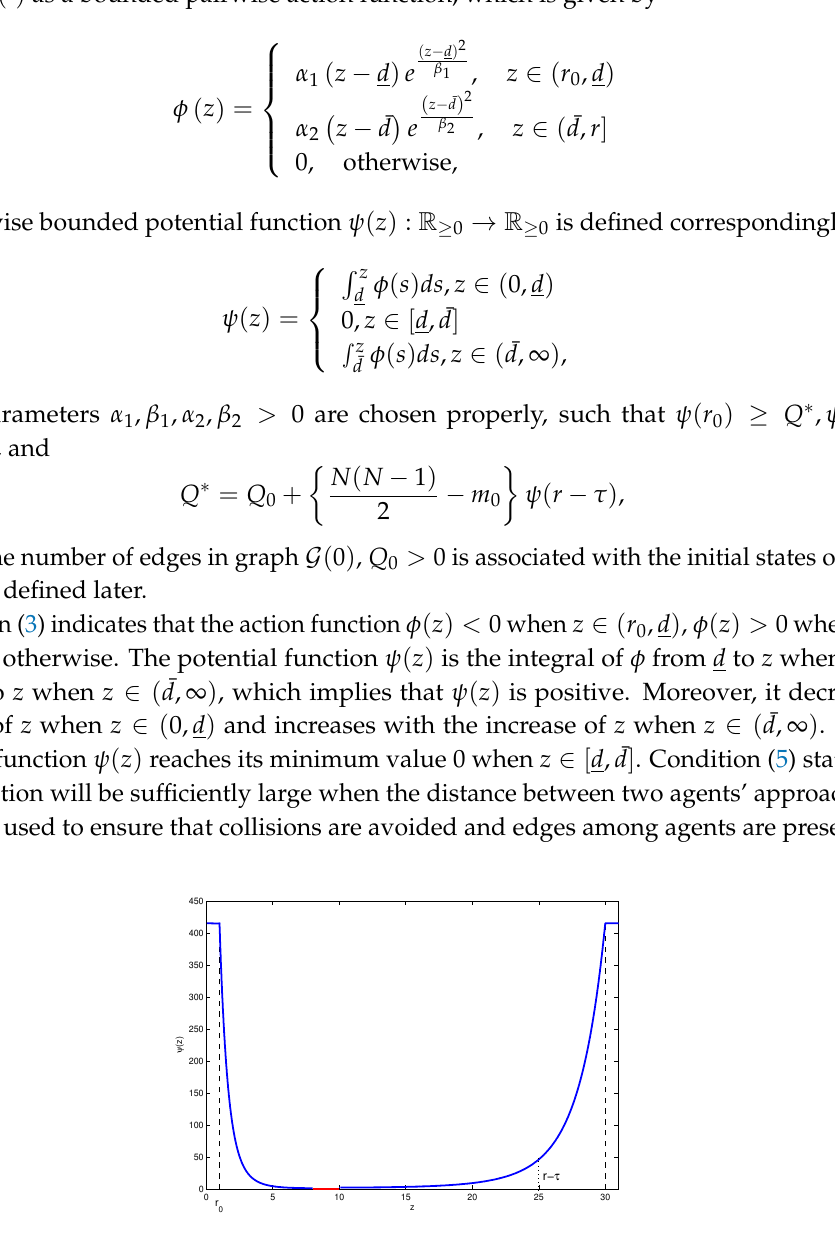
Figure 2. The potential function ψ ( z )